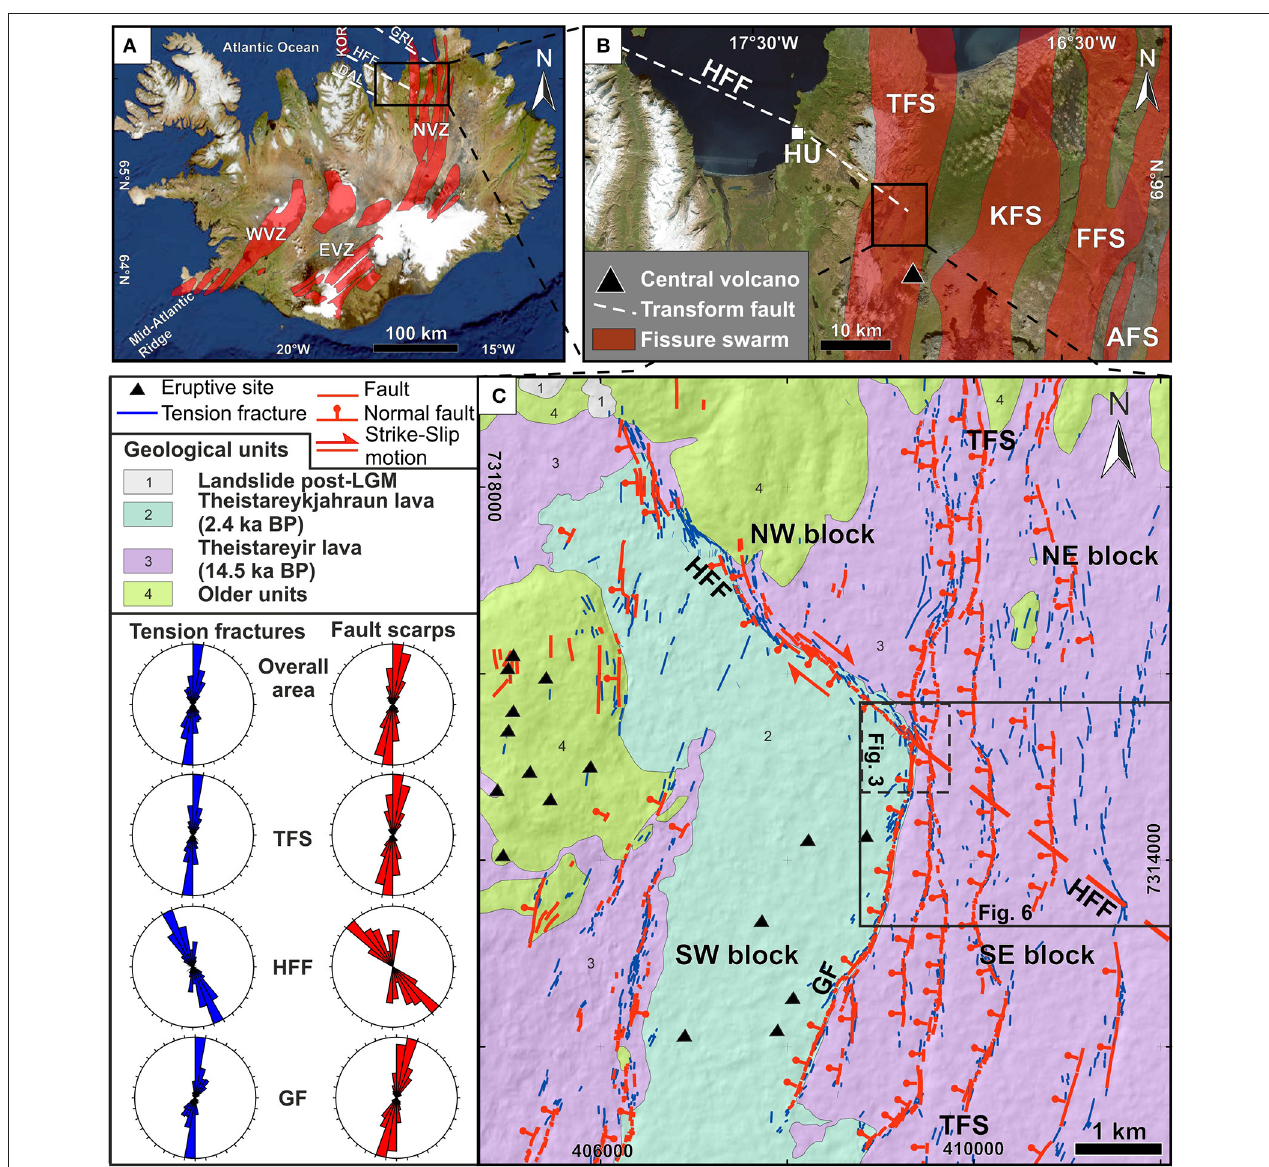
FIGURE 2 | (A) Iceland with its volcanic zones, among which the North Volcanic Zone (NVZ), the West Volcanic Zone (WVZ), and the East Volcanic Zone (EVZ). The Tjörnes transform fault zone is composed of the Dalvik lineament (DAL), the Husavik-Flatey Fault (HFF), and the Grimsey lineament (GRL). KOR, Kolbeinsey ridge. (B) Tectonic setting of northeastern Iceland; orange stripes represent the main volcanic systems that compose the NVZ, among which the Theystareykir Fissure Swarm (TFS), one of the main objects of the present study. Black triangle shows location of Theistareykjabunga shield volcano. (C) Simplified geologic map of the study area (based on personal data and Saemundsson et al., 2012), integrated with a structural sketch map of the eastern portion of the HFF, and a major section of the TFS. Rose diagrams of faults and tension fractures are also provided.